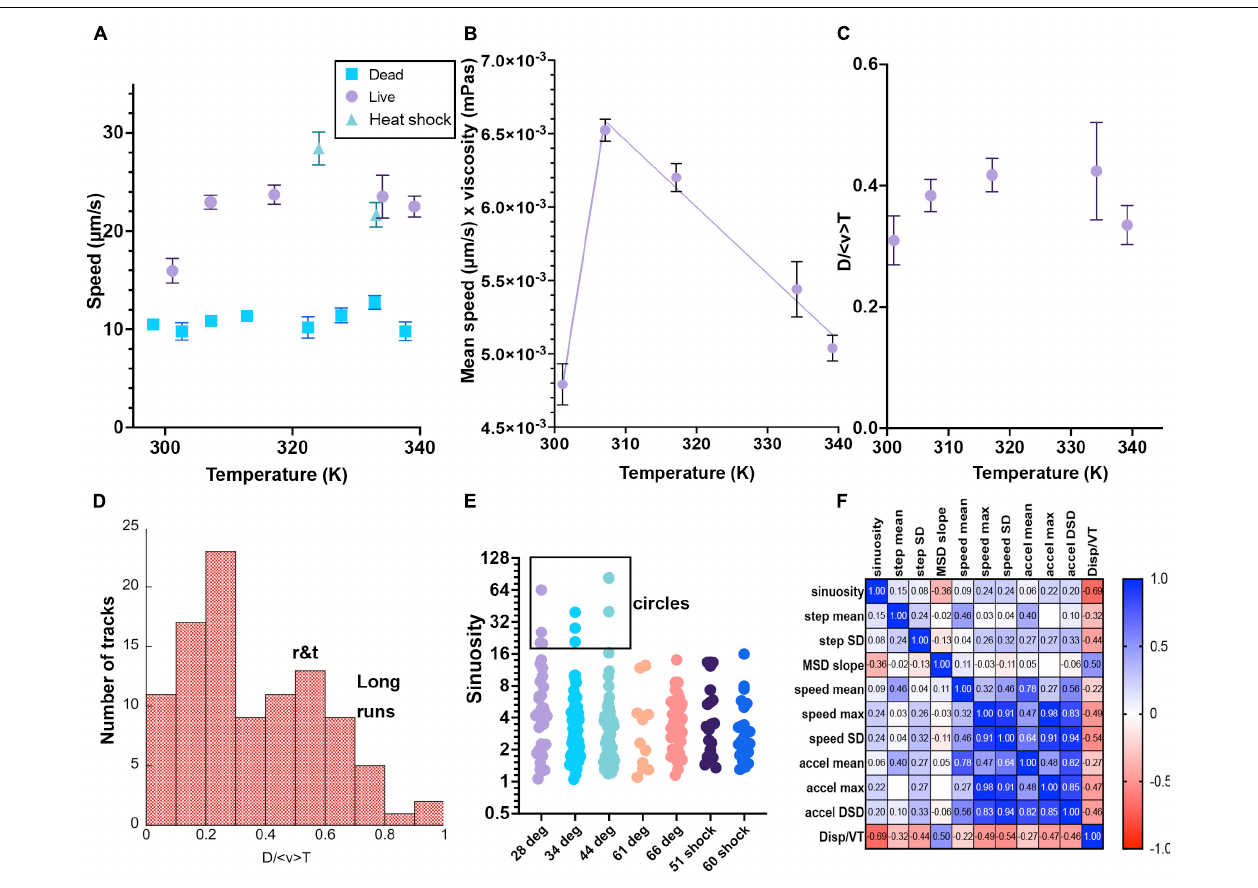
FIGURE 7 | Selected motility parameters. Definitions of the parameters, values and statistical significance are given in the text. Error bars shown are mean ± standard error of the mean unless noted. Numbers of analyzed tracks and their classifications are given in Table 1 . When error bars do not appear, they are smaller than the symbols. (A) Mean speed. (B) Mean speed times viscosity of water at that temperature. The lines are linear fits to temperatures above or below 310 K. (C) Total displacement normalized to track length and average speed < v > . (D) Histogram of selected values of D/ < v > T, showing classification into long runs vs. run-and-tumble traces. (E) Sinuosity (no error bars given as the distributions were not Gaussian and the mean value had little significance). These values are plotted on a Log_2 scale for ease of visualization of the ranges involved. Circular tracks were identified as those with sinuosity > 20. (F) Correlation matrix of the measured